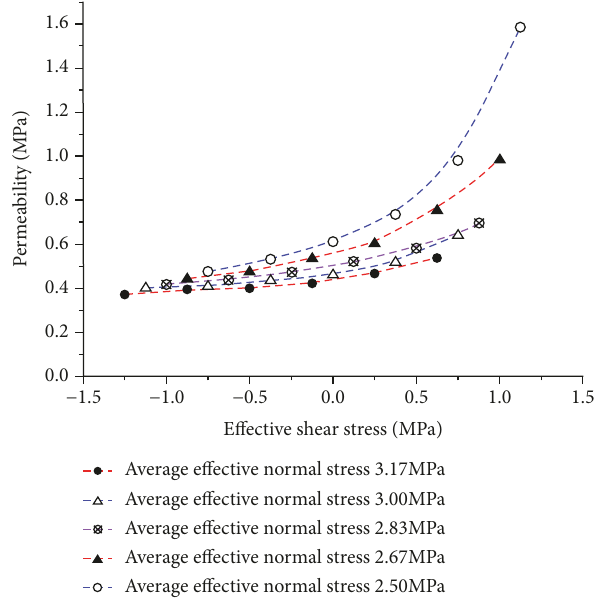
Figure 12: The seepage test results obtained under constant e ff ective normal stress conditions. Table 3: Fitting formula.